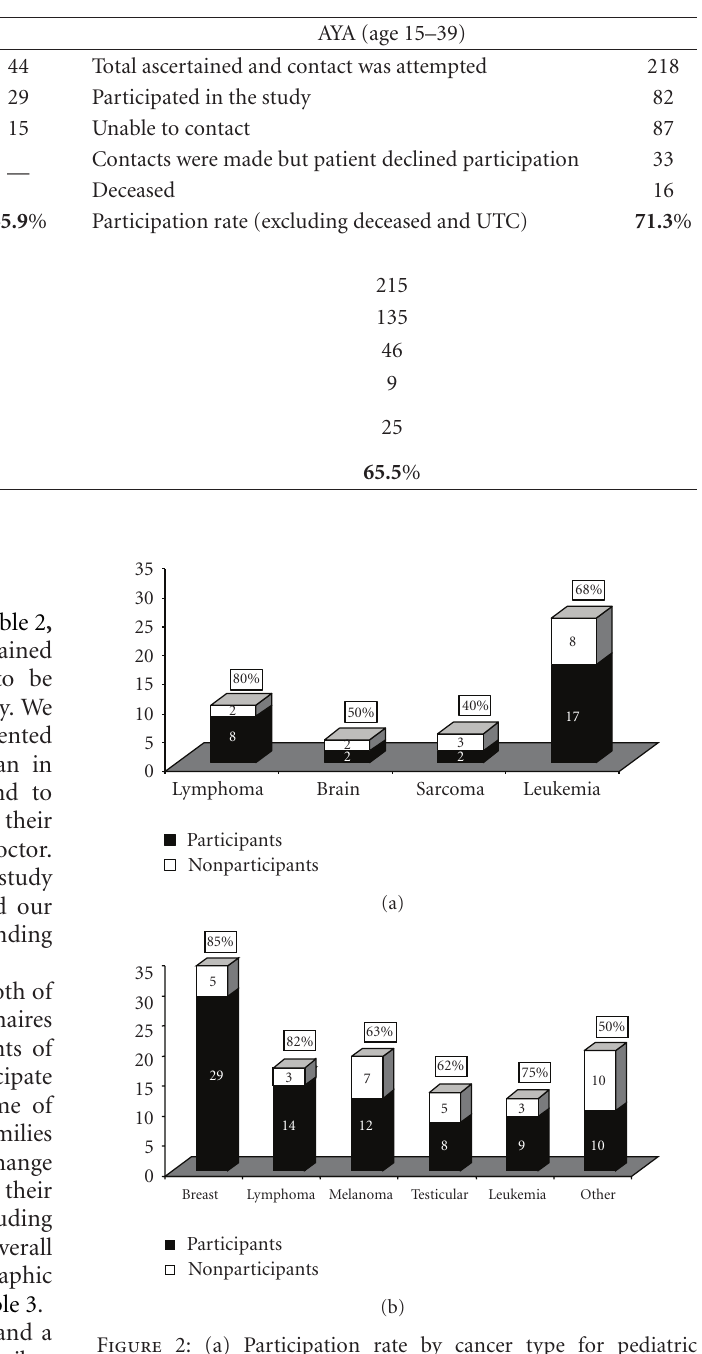
Table 2: Participation by subject type.